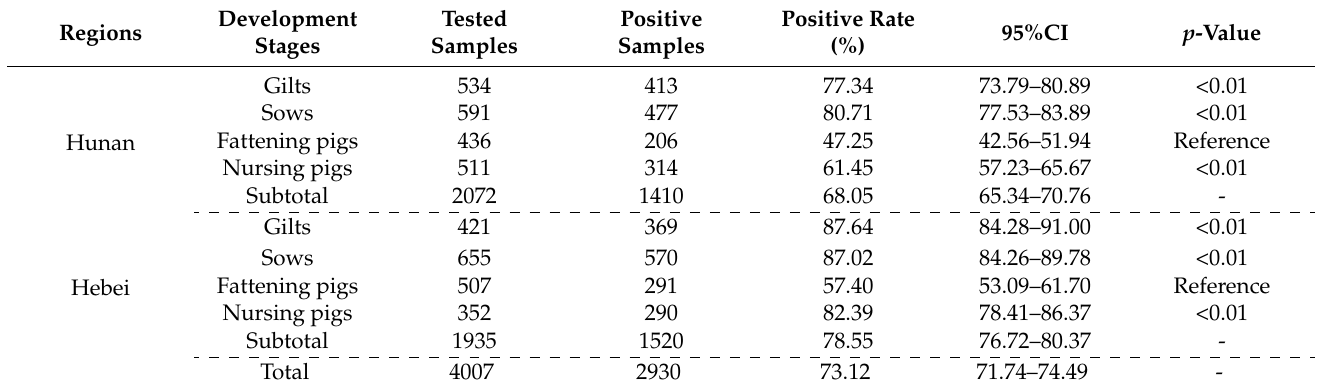
Table 1. Seroprevalence of PRRSV among pigs with different development stages in Hunan and Hebei provinces in China.